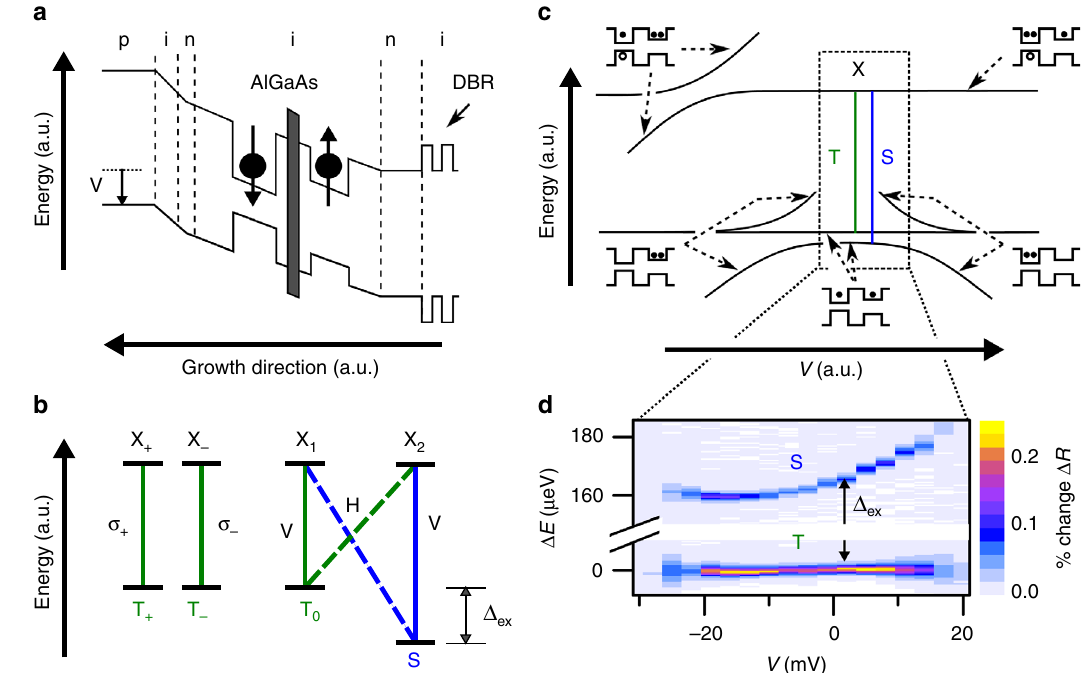
Fig. 1 QDM two-electron charge con fi guration. a Schematic diode band structure and b energy-level diagram of the QDM two-electron charge con fi guration where one electron resides in each quantum dot. The electrons are tunnel coupled through a thin barrier (details in Methods) forming spin singlet (S) and triplet (T 0 , T + , and T − ) ground states. The S and T 0 states form two overlapping Λ systems with two exciton states through vertical (V, solid) and horizontal (H, dashed) linearly polarized optical transitions. c Schematic bias dependence of the lowest ground and excited energy levels for a QDM charged with two electrons. When both electrons reside in one quantum dot, they form a spin singlet and anti-cross with S, pushing the energy level down by the exchange splitting ( Δ ex ). The boxed region corresponds to the bias range where two electrons are stable in the QDM, determined by d differential re fl ectance spectra. All energies are given relative to the triplet transition energy (1307.8 meV) and labeled as Δ